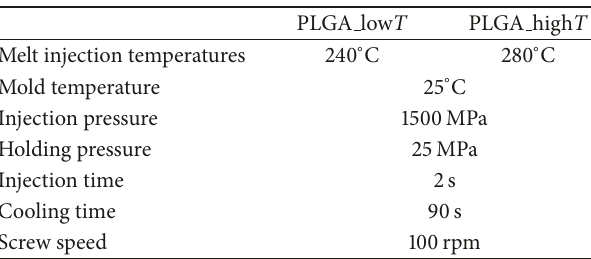
Table 1: Injection molding parameters used to produce PLGA plates. All the production parameters were kept constant while varying the melt injection temperature (240 ∘ C for PLGA low T and 280 ∘ C for PLGA high T